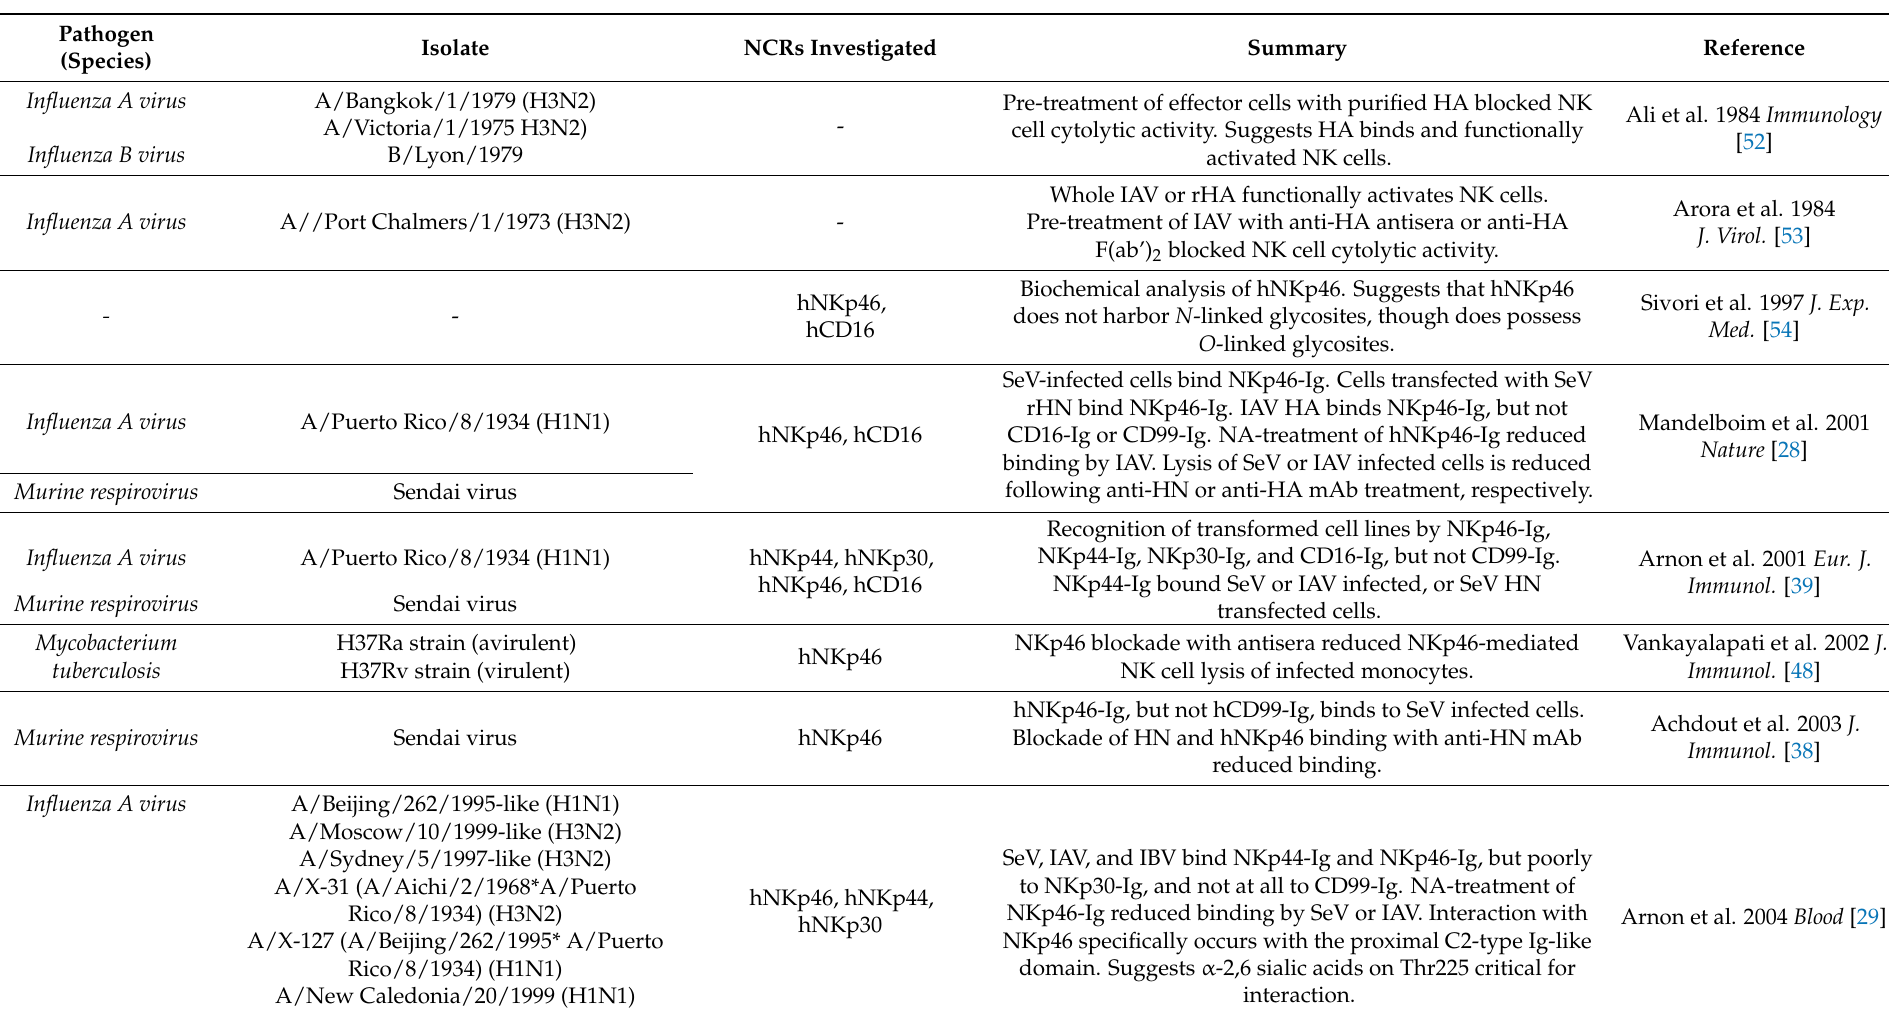
Table 1. Selected literature describing viral, bacterial, and parasite interactions with the natural killer cell natural cytotoxicity